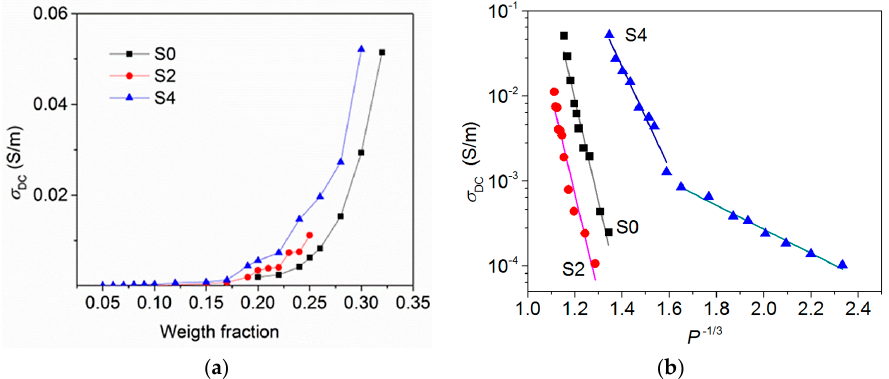
Figure 4. σ DC as the function of filler weight fraction ( a ) and log σ DC as the function of filler volume fraction ( b ) measured for polystyrene (PS) composites with S0, S2, and S4 powders.